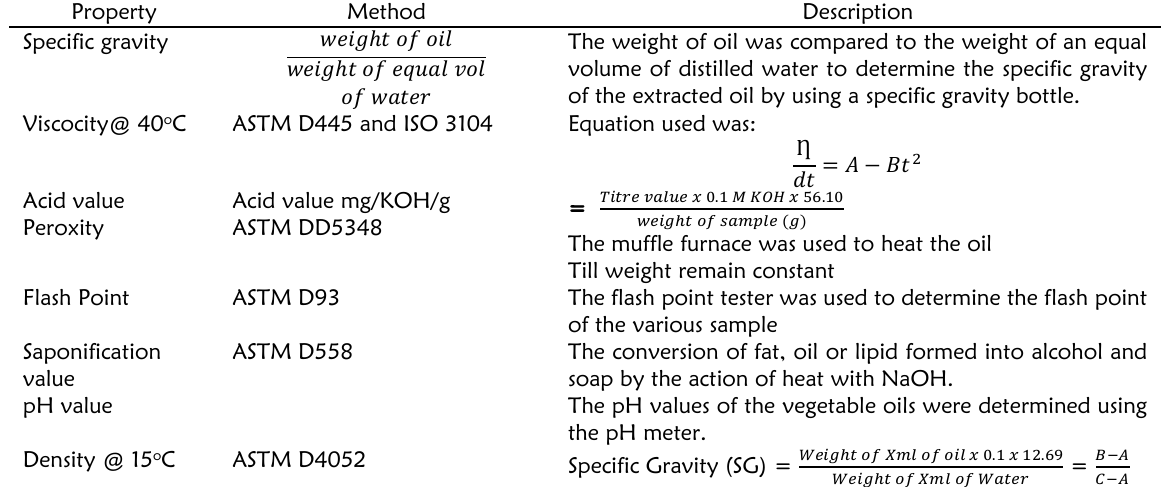
Table 1: Jatropha oil Physiochemical Properties